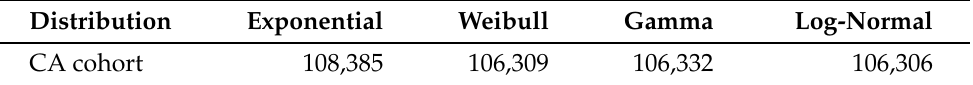
Table 3. Goodness-of-fit statistics (BIC) of the cross-selling times T for the CA cohort. Distribution Exponential Weibull Gamma Log-Normal CA cohort 108,385 106,309 106,332 106,306